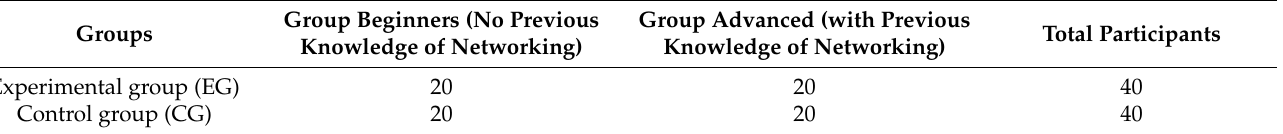
Table 2. Working